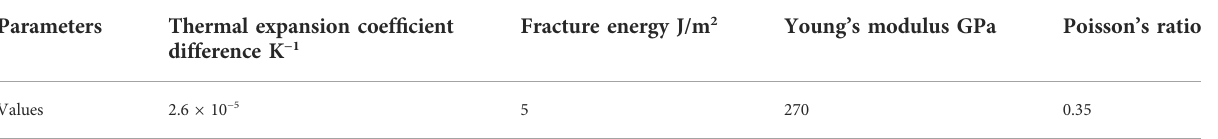
TABLE 1 The parameters used for magnesium oxide spallation diagram calculation (Mitchell 1999).